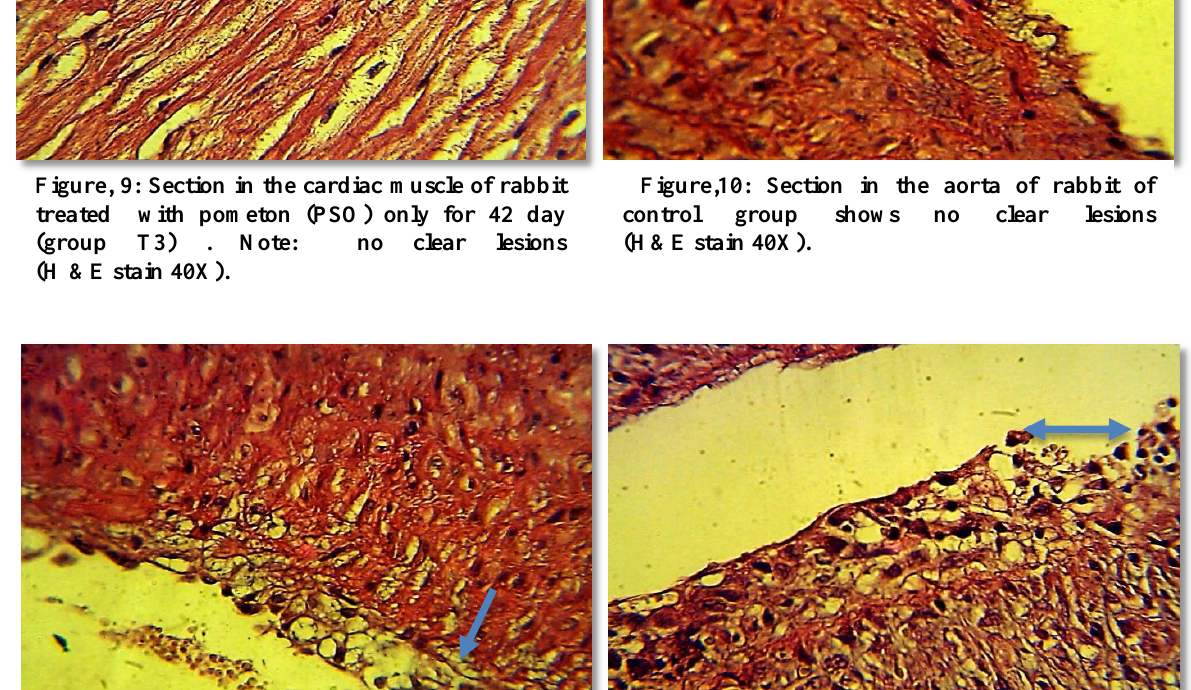
Figure,11: Section in the aorta of rabbit after 42 day of treatment with methionine over load (group T1) .Note: increase thickness of intima due to vacuolar cells aggregation in subintima (H &E stain 40X).